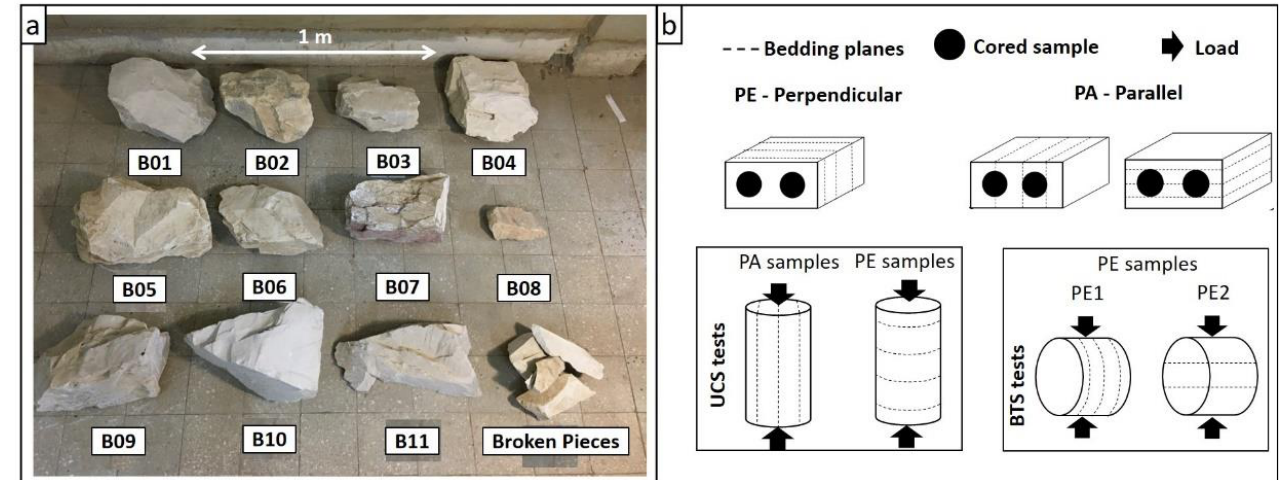
Figure 3. Sample preparation considerations followed in this research, showing ( a ) picture of all rock blocks collected from the KV during the field campaign in February 2019 (locations highlighted in Figure 2a) and ( b ) a sketch of the nomenclature to define Parallel (PA) and Perpendicular (PE) orientations of coring, as well as a sketch to show the loading direction for Unconfined Compressive Strength (UCS) and Brazilian Tensile Strength (BTS) tests. BTS tests were conducted only in PE, for 2 configuration of loading and anisotropy